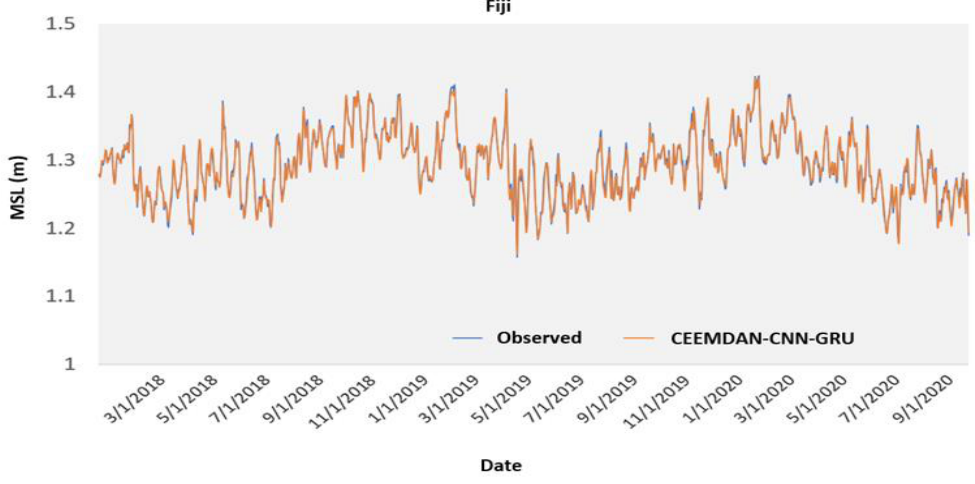
Figure 14. Comparison between Forecasted and Observed MSL during the 2018 – 2020 period for the CEEMDAN-CNN-GRU